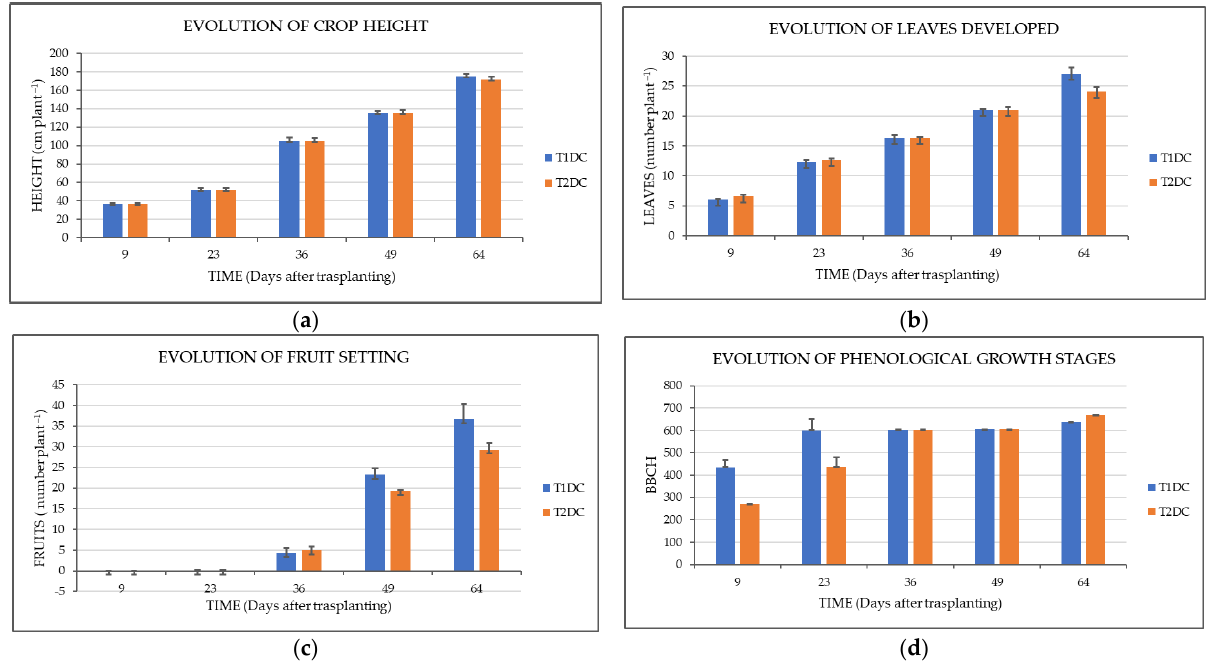
Figure 8. Growth parameters of tomato crops grown in coconut fiber above PVC trays: ( a ) evolution of height; ( b ) evolution of leaves developed; ( c ) evolution of fruit setting; ( d ) evolution of phenological growth stages.